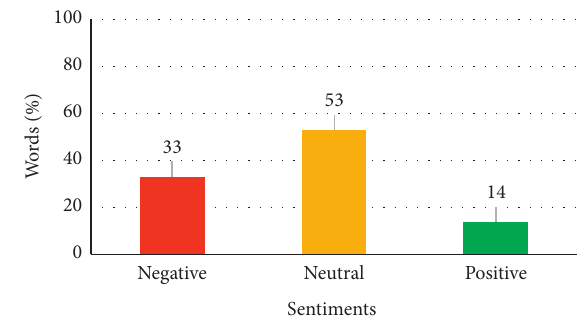
Figure 2: The prior distribution of the sentiment texts or